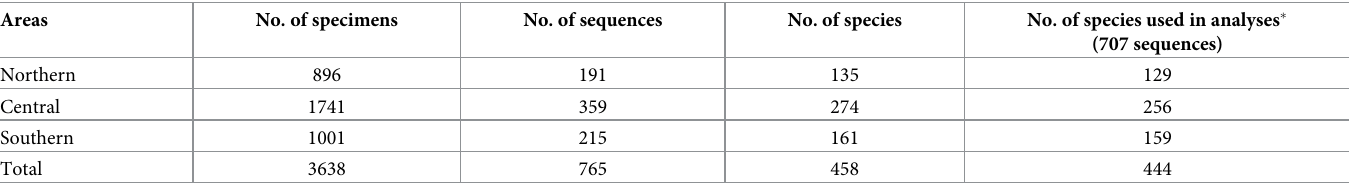
Table 1. Summary of specimens, sequences and species number in each area in this study.